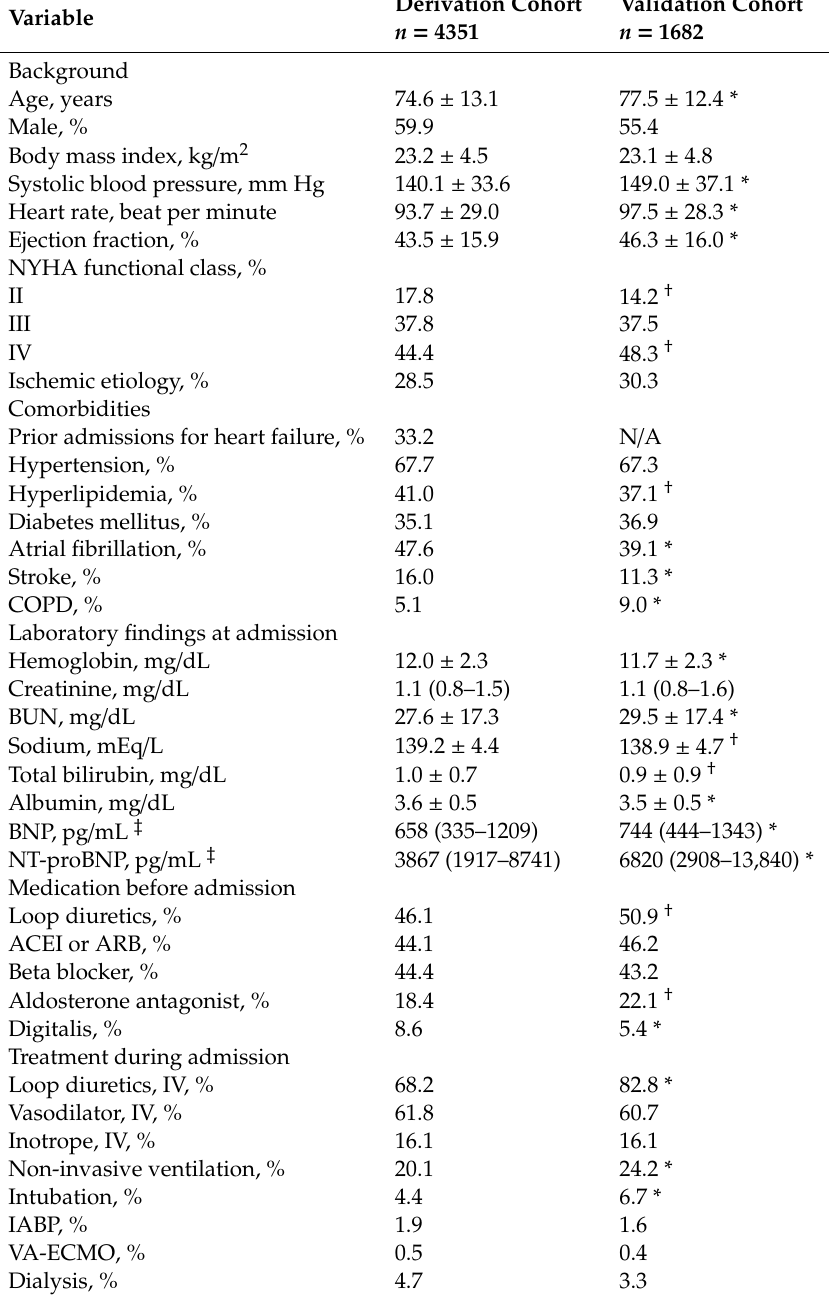
Table 1. Baseline